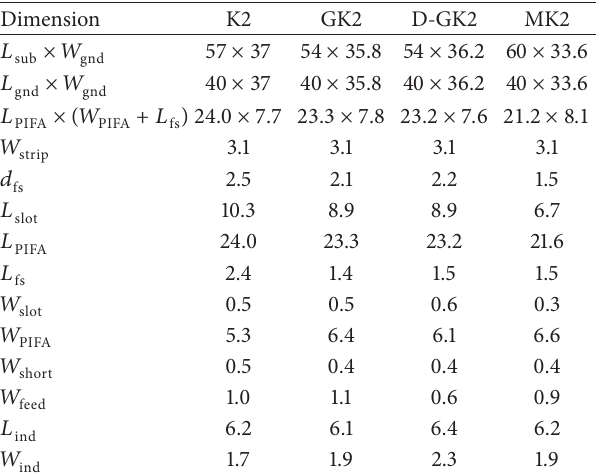
Table 2: Values of parameters that determine the design of the four proposed dual-band PIFAs. All dimensions are in